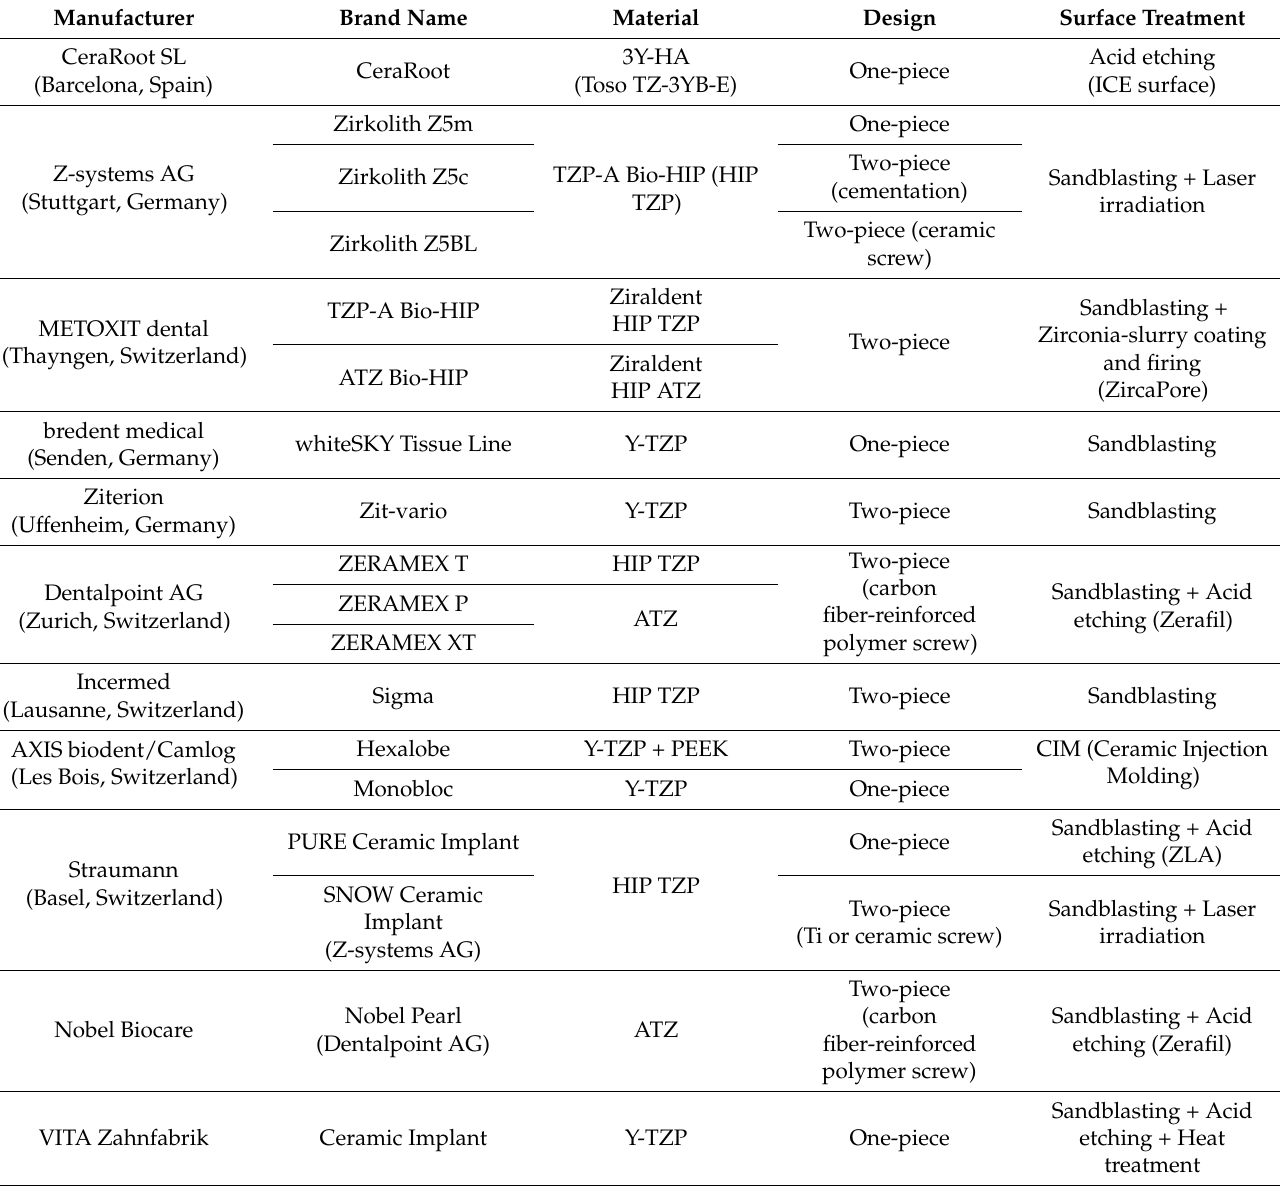
Table 3. Commercially available zirconia implant